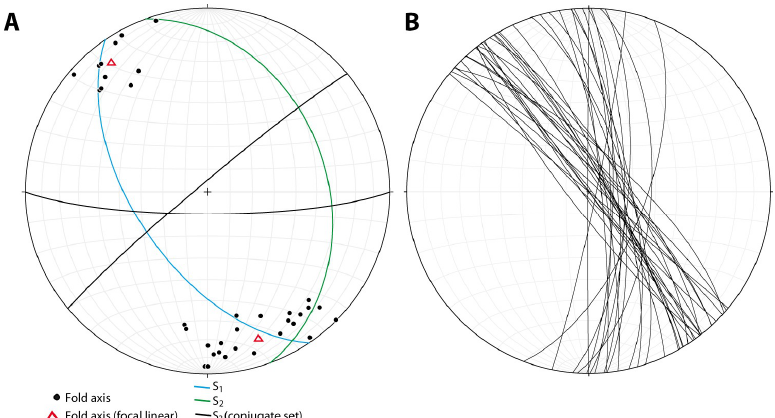
Figure 7. Schmidt nets with equal lower hemisphere projection. ( A ) Orientation of the 36 fold axes in Am 1 and Am 2, as well as representative S 1 (Am 1 and 2), S 2 and S 3 (Am 1) values. There is a clear geometric relationship between the fold axes on the one hand and S 1 , S 2 , and S 3 on the other hand. S 1 and S 2 strike approximately parallel to the fold axes while S 3 strikes perpendicularly to the fold axes. ( B ) Orientation of the fold axial planes of the 36 folds. Geosciences 2019 , 9 , x FOR PEER REVIEW